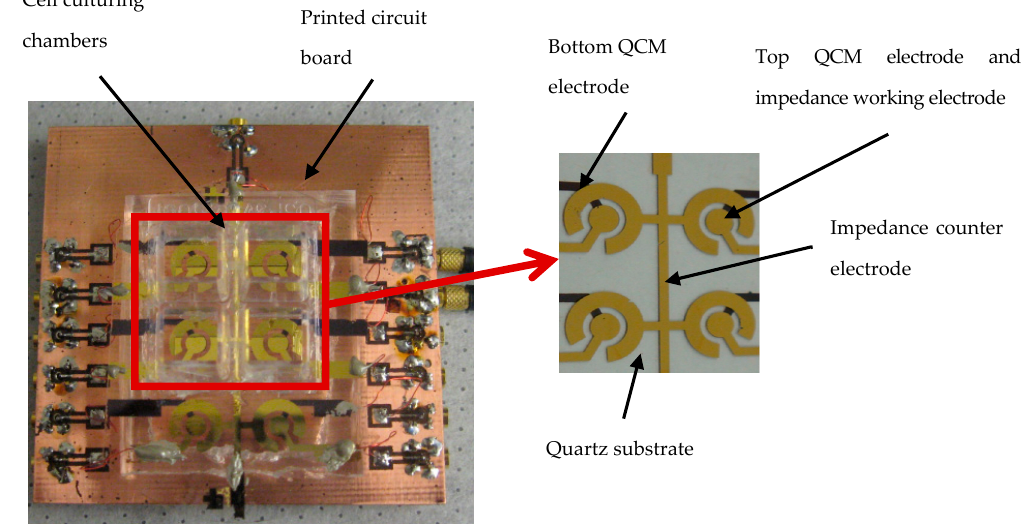
Figure 7. The image of the fabricated hybrid sensors configuration (2 × 3 array) on PCB with magnification of 4 sensors, adopted from [81].